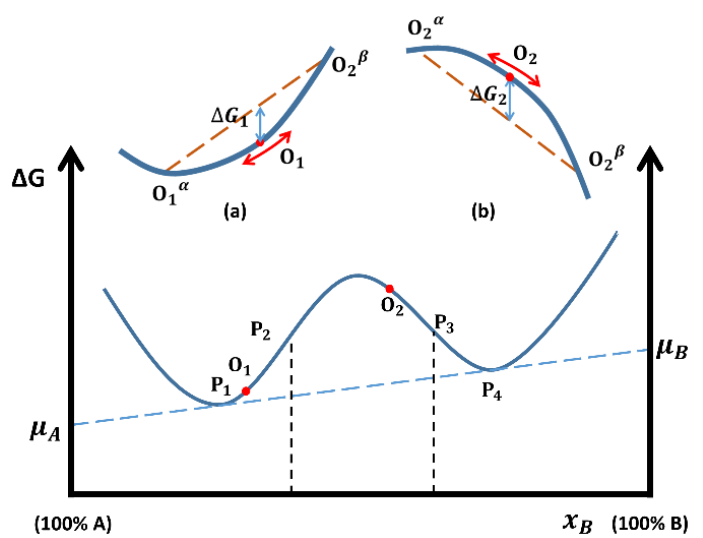
Figure 4. Gibbs free energy-composition diagram method for determining the driving force for phase separation. Recreated from [80].